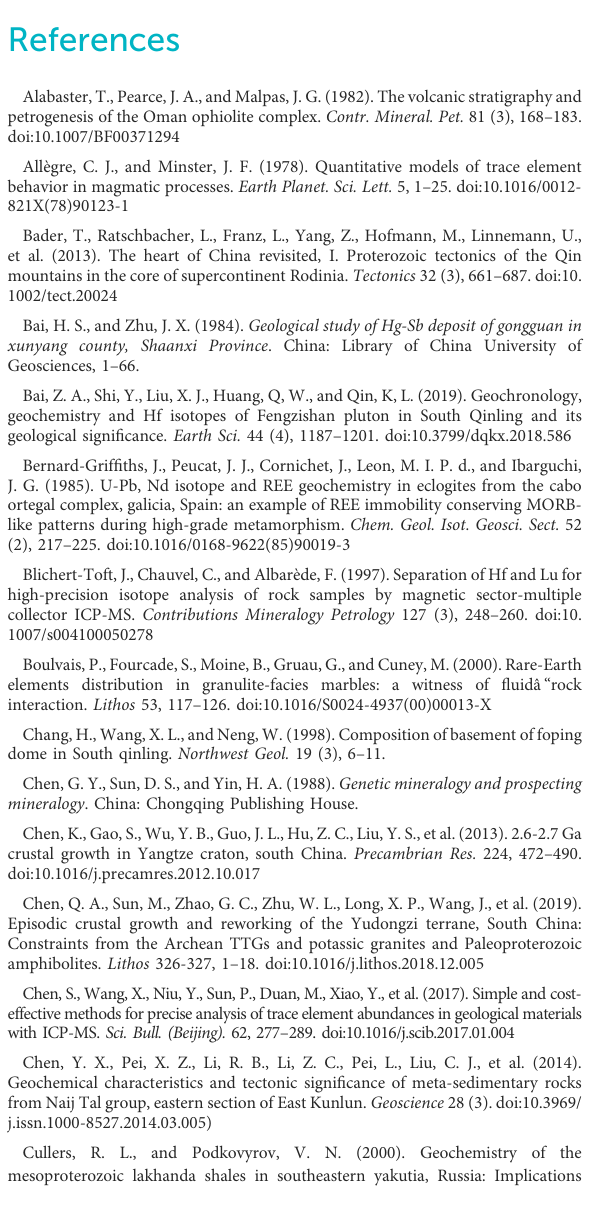
SUPPLEMENTARY FIGURE S1 REE-La/Yb(modi fi edfromAllègreetal.(1978)),blackcirclerepresentsthe schist in Xunyangba area.